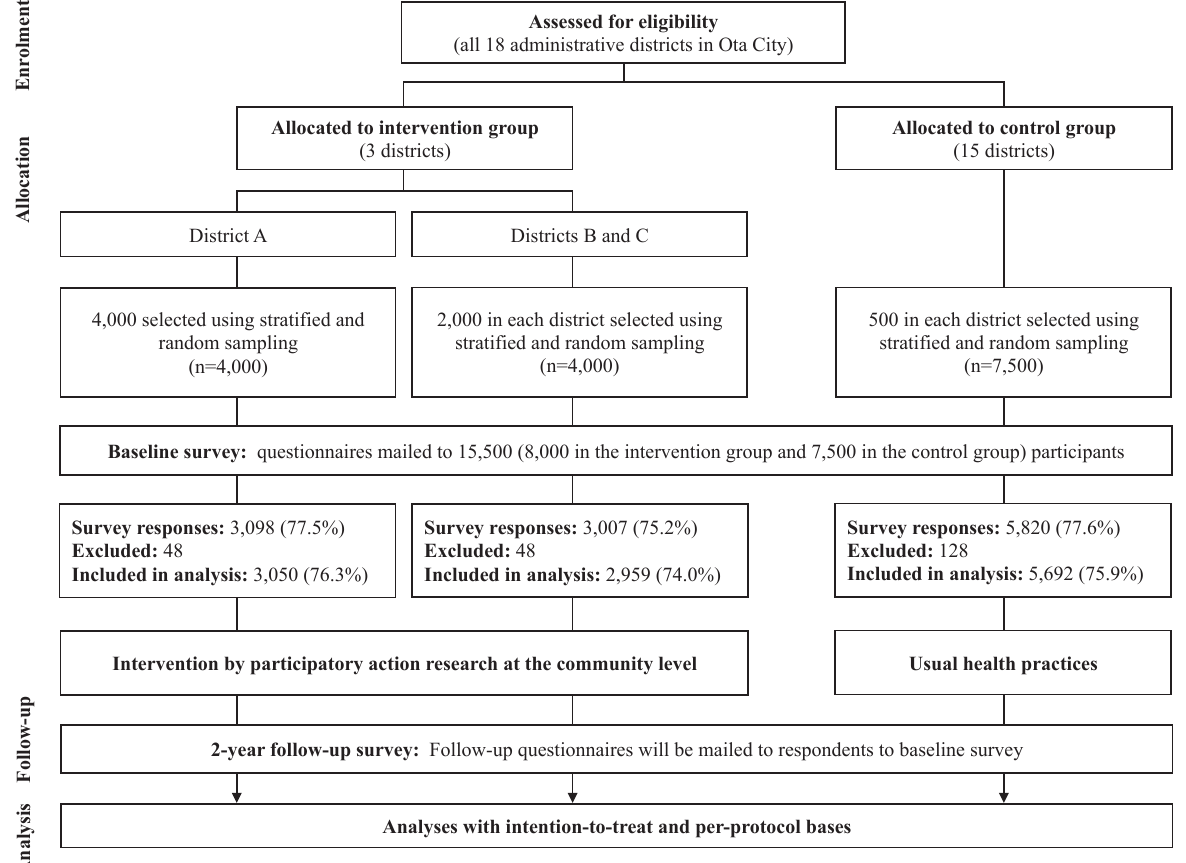
Figure 3. Flow diagram of progress in the Ota Genki Senior